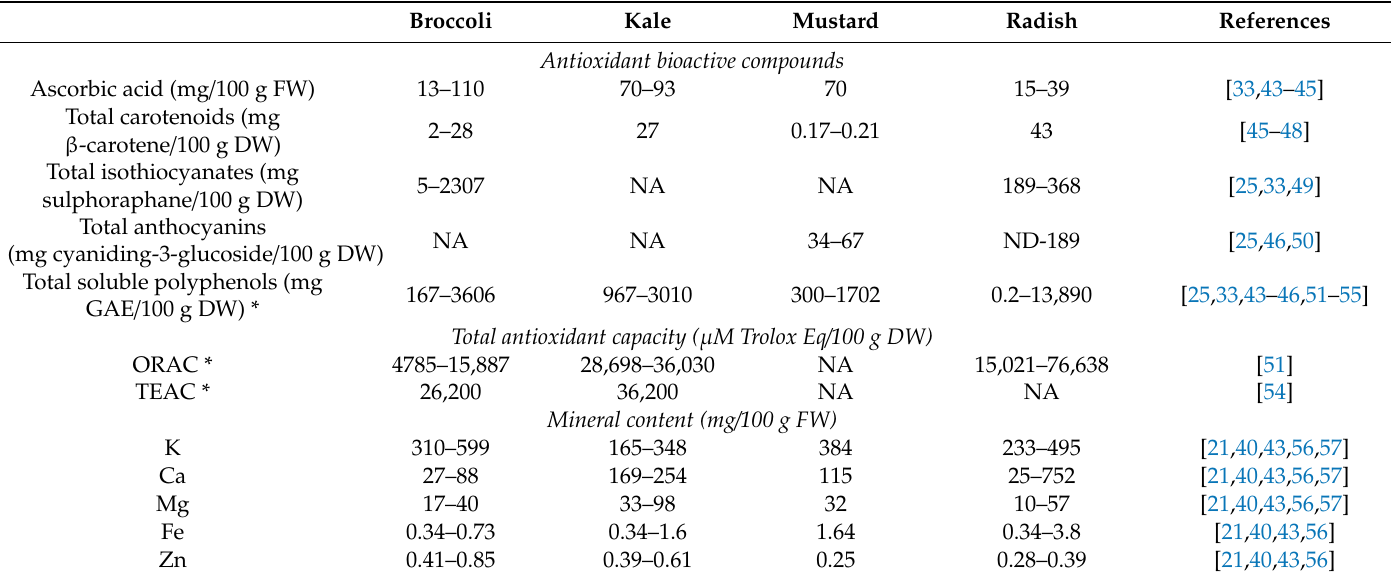
Table 2. Antioxidant bioactive compounds and mineral elements content in mature counterparts of the microgreens evaluated in this study. Broccoli Mustard